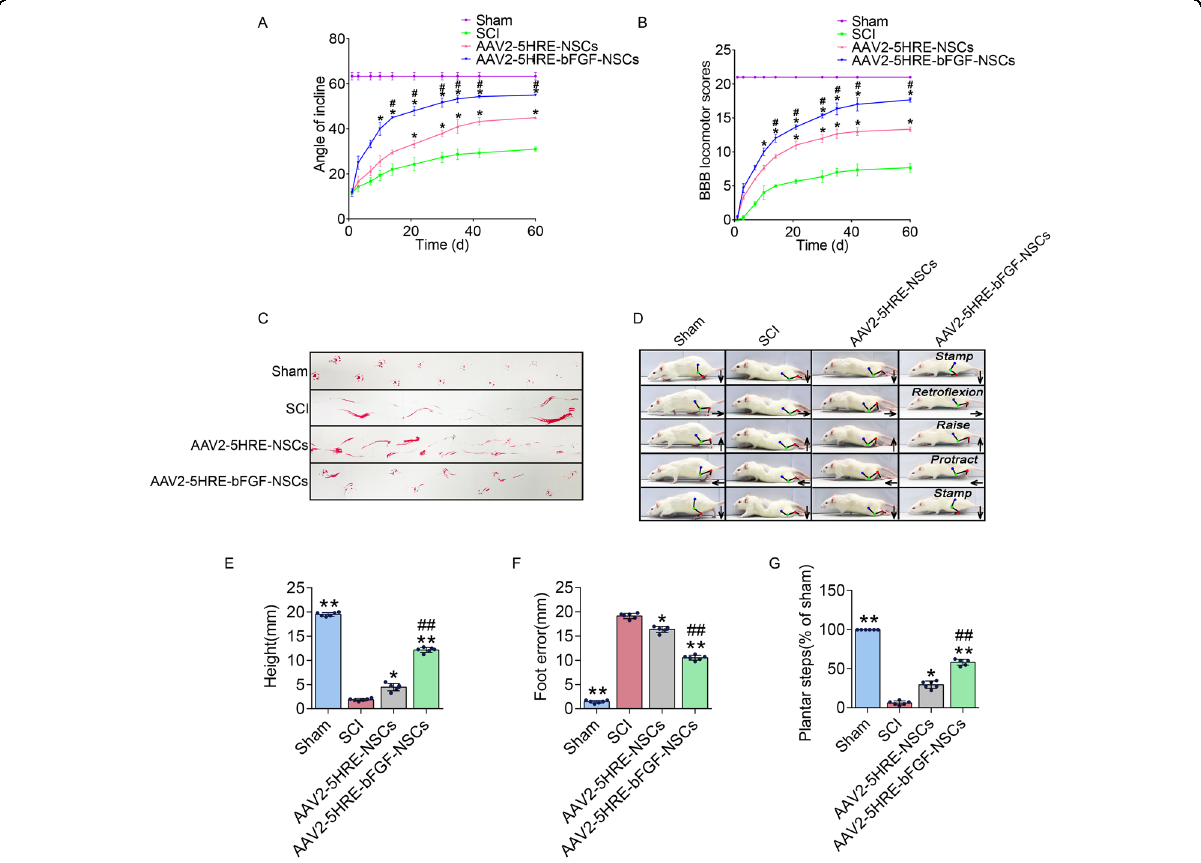
Fig. 2 AAV2-5HRE-bFGF-NSCs improve the recovery of SCI rats. A The inclined plane test scores of sham, SCI group, AAV2-5HRE-NSCs group, and AAV2-5HRE-bFGF-NSCs group. B The BBB scales of sham, SCI group, AAV2-5HRE-NSCs group, and AAV2-5HRE-bFGF-NSCs group. “ # ” represents P < 0.05, AAV2-5HRE-NSCs group verse SCI group, “ * ” represents P < 0.05, AAV2-5HRE-bFGF-NSCs verse AAV2-5HRE-NSCs group. Data are the mean values± SEM ( n = 3). C Footprint analyses of sham, SCI group, AAV2-5HRE-NSCs group, and AAV2-5HRE-bFGF-NSCs group. D Video sequences of a rat walked 2 months after SCI were analyzed as previously described 40 , including weight support, leg extensor spasms, slow steps, and foot placement. Arrow denotes foot movement. Scale bar = 20 mm. E Weight support (quanti fi ed as the height of the trunk from the ground), F Foot error, and G Plantar step were presented. “ ** ” represents P < 0.01, versus the sham group or SCI group, “ ## ” represents P < 0.01, versus the AAV2-5HRE-NSCs group. Data are the mean values± SEM ( n =